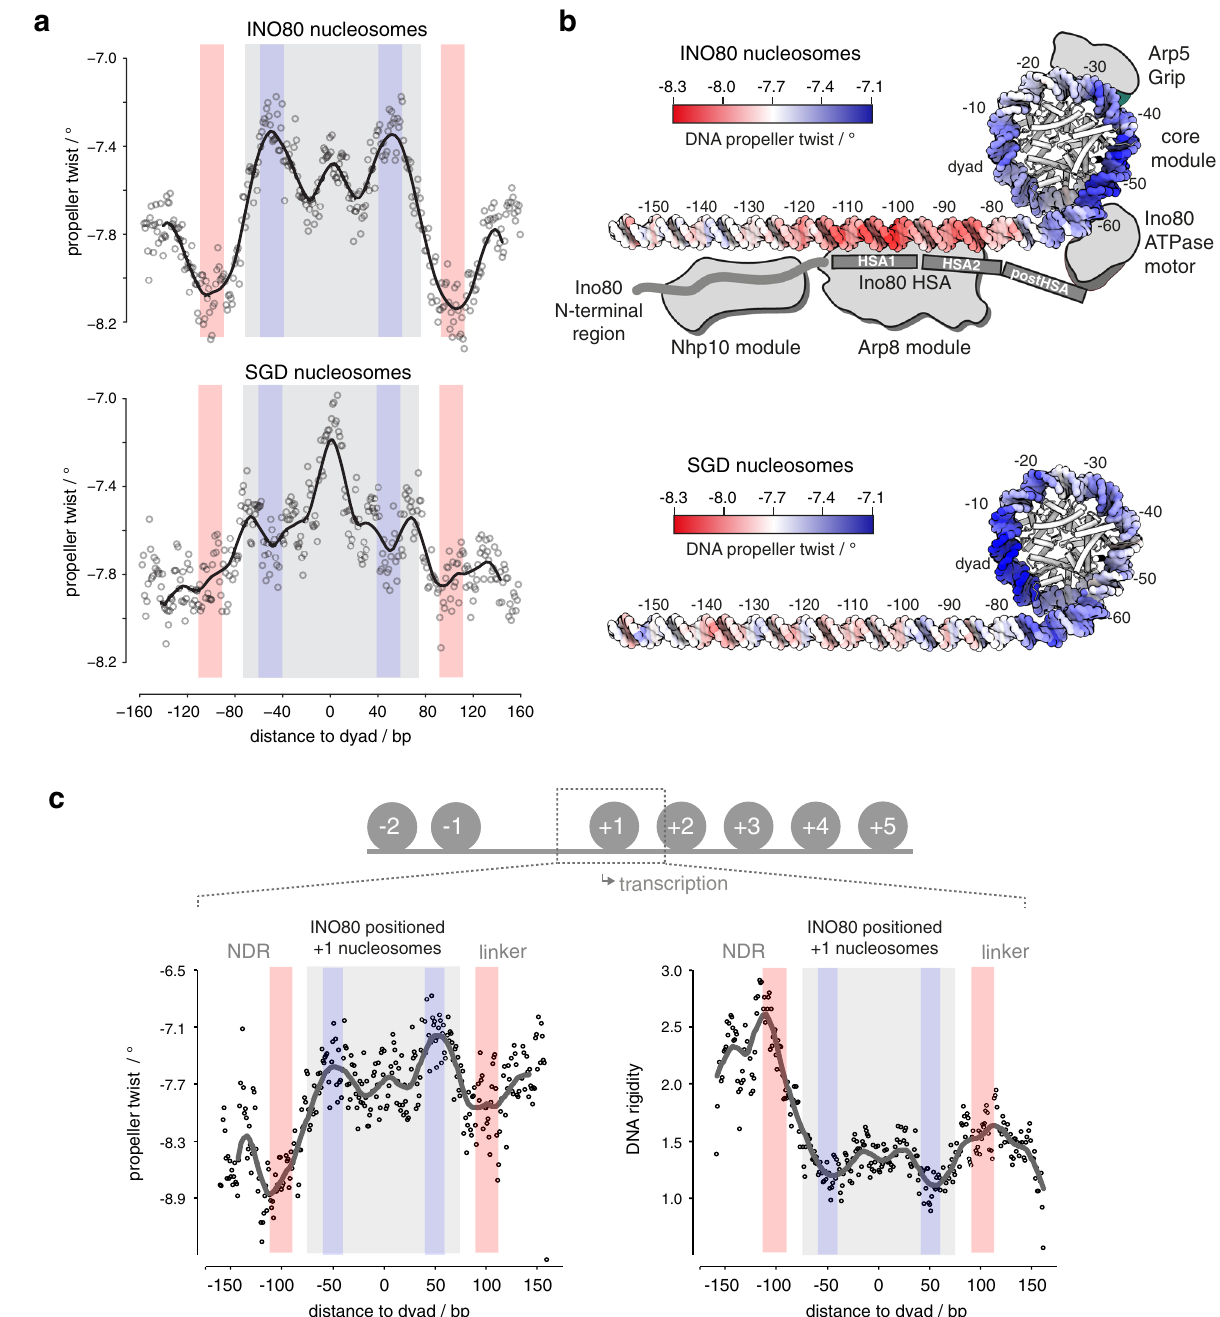
Fig. 4 DNA shape/mechanics readout underlies nucleosome positioning by INO80 and SGD. a Propeller twist DNA shape pro fi les for nucleosomal sequences occupied by histones in SGD chromatin with (INO80 nucleosomes, 1295 sequences, clusters 3, 5, 6, 7, and 8 as de fi ned in Fig. 3b) or without (SGD nucleosomes, 1098 sequences, clusters 1, 2, and 4 as de fi ned in Fig. 3b) remodeling by recombinant S. cerevisiae WT INO80 complex. Light red and light blue background indicate regions of major differences between SGD and INO80 pro fi les. Light gray background marks the extent of the nucleosome core particle. b Red – white – blue color gradient mapping of propeller twist DNA shape pro fi le from a on model of linker and nucleosomal core DNA. Binding architecture of INO80 is shown schematically and based on structural data 44,47 and biochemical mapping 48 . c Propeller twist DNA shape and DNA rigidity pro fi les for INO80-positioned + 1 nucleosomes, all with the same orientation relative to the direction of transcription. See main text and “ Materials and methods ” for a description of the DNA rigidity score. Note that the promoter NDR around − 100 bp corresponds to a rigid DNA motif, while the score indicates increased fl exibility around − 55 bp between the ATPase motor and the Arp5 grip of INO80 (see b